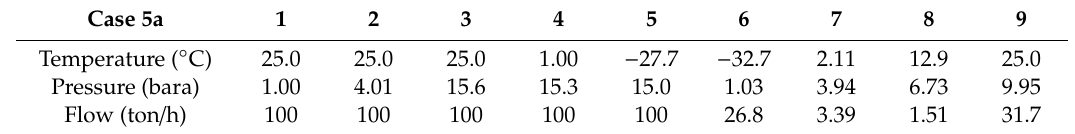
Table A10. Mass balance for Case 5a, stream numbering from Figure 2.